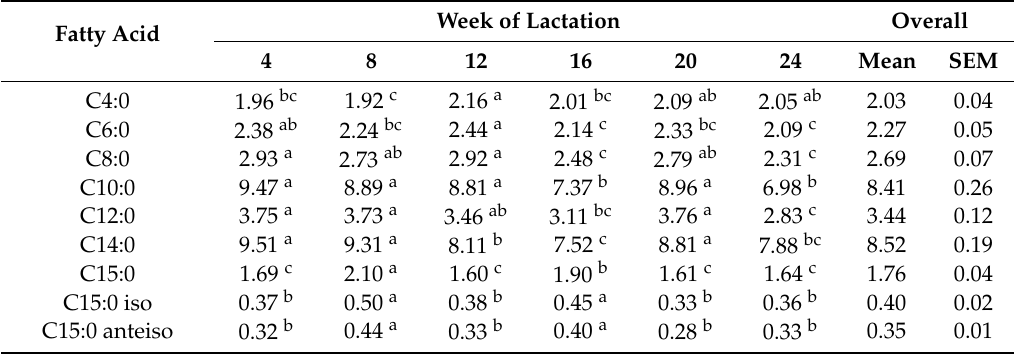
Table 4. Least squares means of individual, groups (g / 100 g of total identified fatty acids), and indices of goat milk fatty acids throughout lactation 1 ( p <